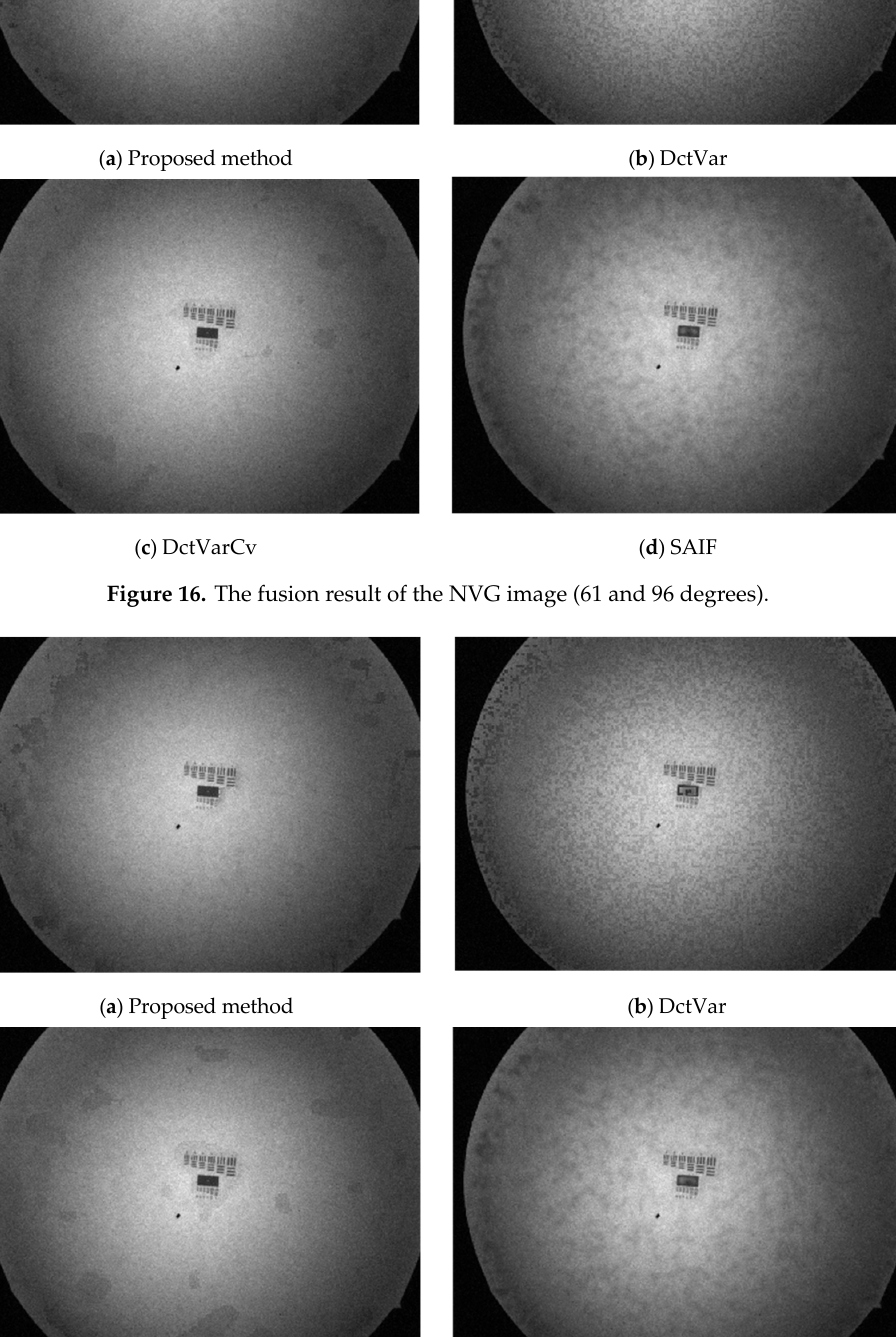
Figure 17. The fusion result of the NVG image (62 and 96 degrees).